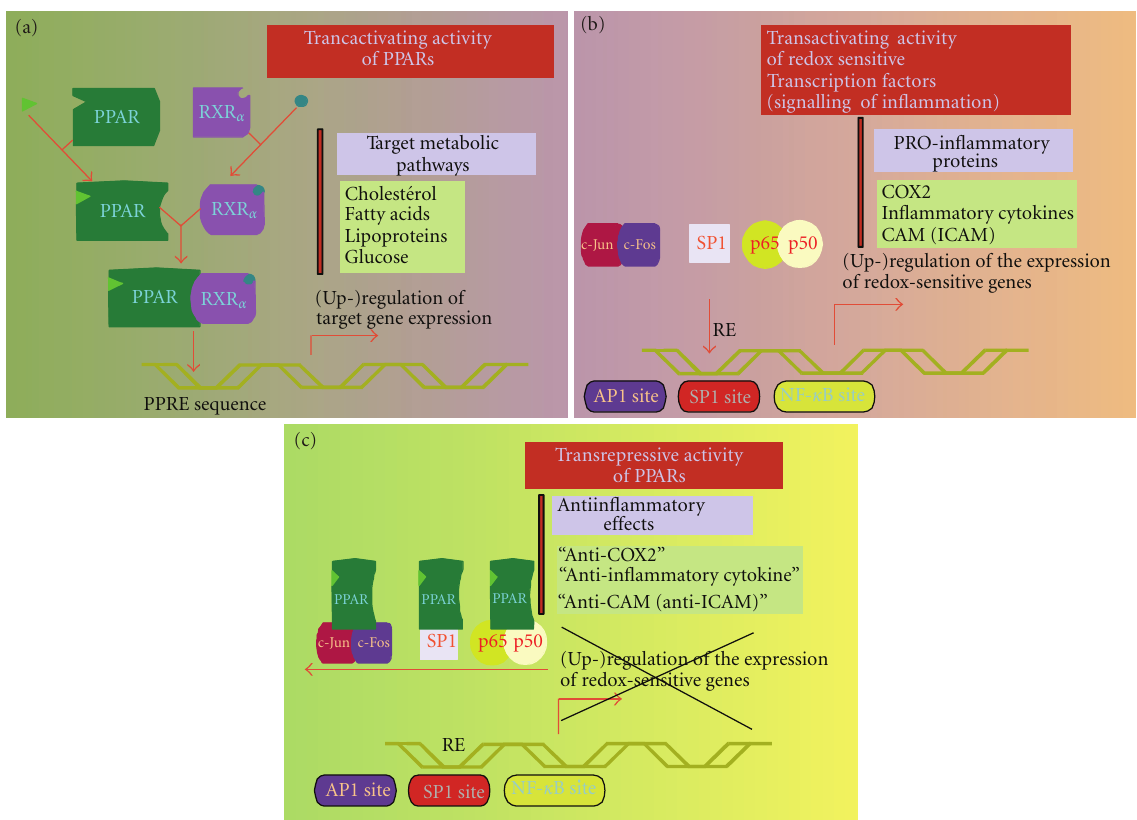
Figure 5: Modulation of gene expression by PPARs and inflammatory transcription factors: transactivation and transrepression mechanisms. The activation of PPARs (a) and inflammatory transcription factors (b) modulates gene expression via specific response elements (RE), resulting mainly in the upregulation of proteins involved in several metabolic and inflammatory pathways, respectively. The two routes may connect through protein-protein interaction upstream to DNA-protein interaction (c). This transrepressive action of a pathway on the other is a basis for the anti-inflammatory/antioxidative properties of PPARs, and though less often mentioned, for the anti- PPAR properties of inflammatory/oxidative processes. Abbreviations: COX2, cyclooxygenase 2; ICAM, inducible cell adhesion molecule; PPRE, PPAR-responsive element; RXR α , retinoid acid X receptor α . The mechanisms by which metabolic changes and anti-inflammatory properties induced by PPARs interfere with the Warburg’s e ff ect and cancer development are considered in the